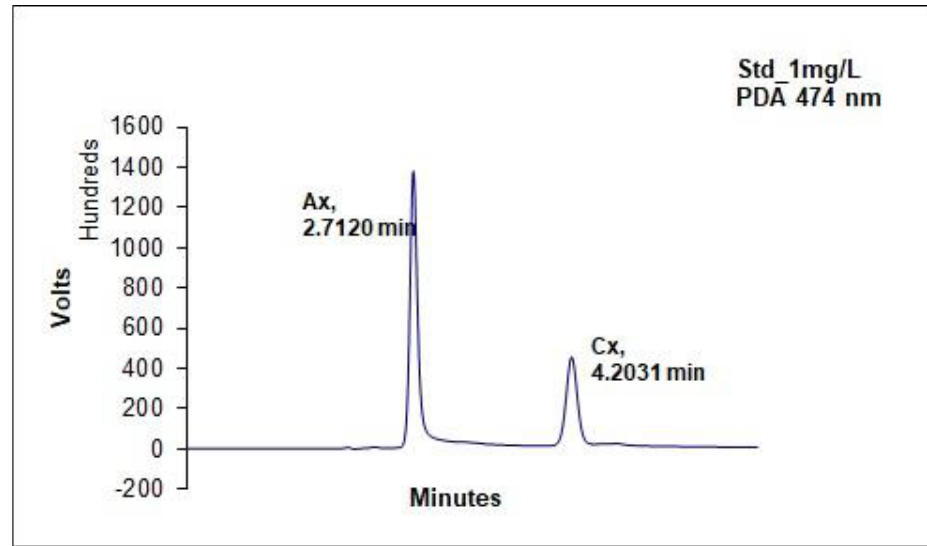
Figure 1. Typical chromatogram of standard solution.